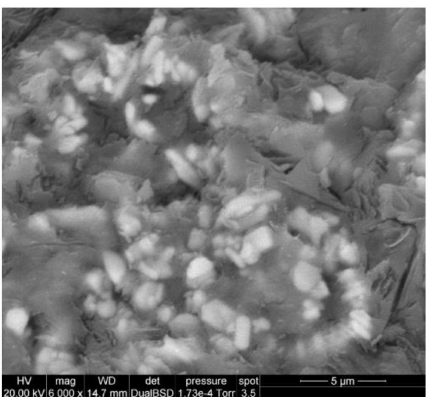
Figure 16. Selected ESEM image of magnetic particles aggregates in